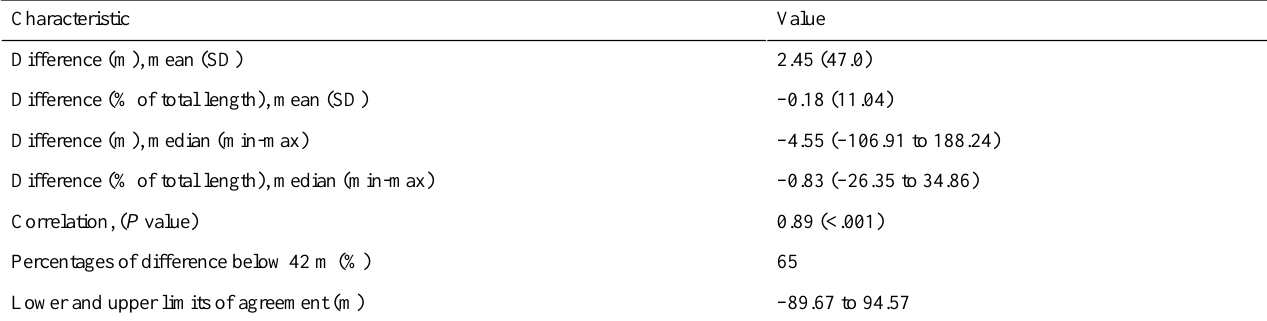
Table 2. Differences between 69 pairs containing a 6-minute walk test distance (6MWD) estimated by a physiologist during a clinic and a 6MWD measured by the app in outdoor mode within 7 days of the clinic test.